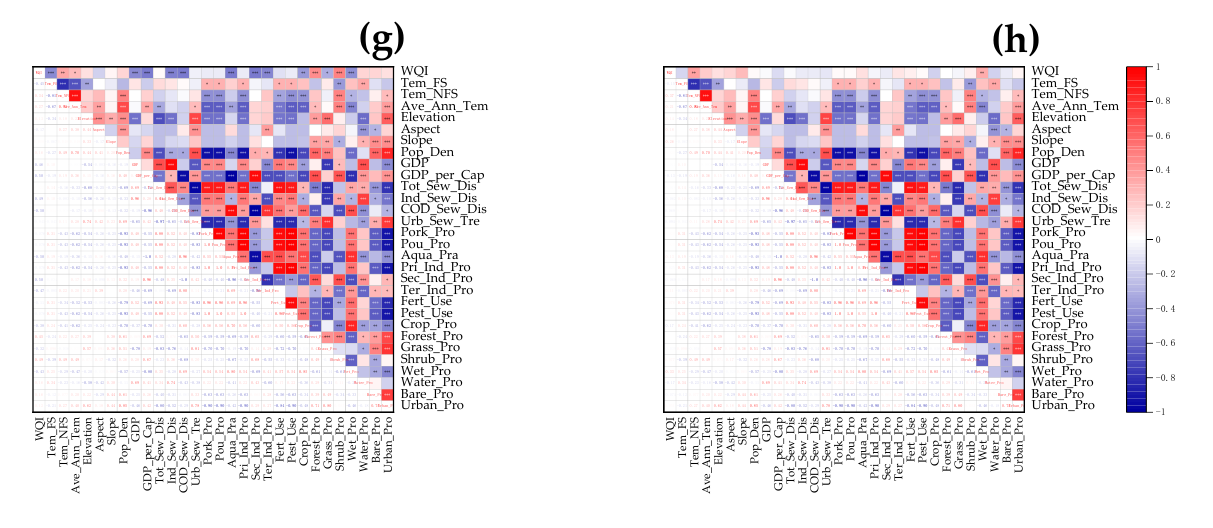
Figure 5. Distribution of single factor pollution index. * p < 0.10, ** p < 0.05, *** p < 0.01. a TN actuation analysis in flood season; b TN actuation analysis in non-flood season; c TP actuation analysis in flood season; d TP actuation analysis in non-flood season; e DO actuation analysis in flood season; f DO actuation analysis in non-flood season; g WQI actuation analysis in flood season; h WQI actuation analysis in non-flood season. Table 7. Spearman correlation analysis summary results.